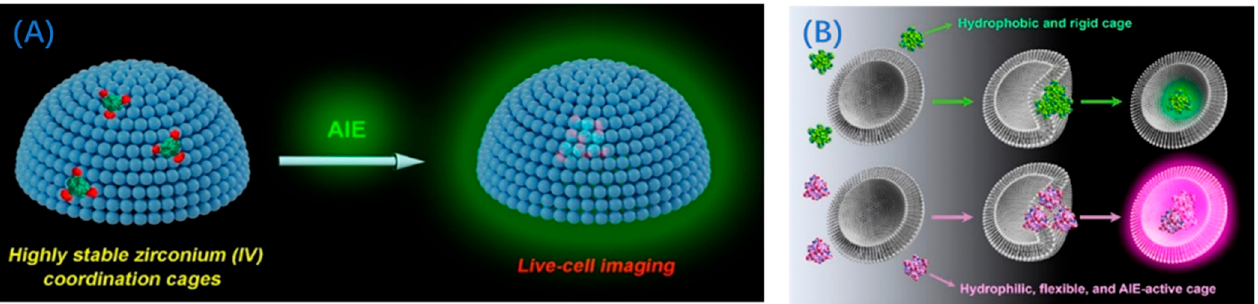
Figure 5. ( A ) Schematic diagram of the application of self-assembly of a highly stable Zirconium(IV) coordination cages containing AIE molecular rotors for live cell imaging (red color groups: the AIE molecular rotors). ( B ) AIE-active POCs with hydrophilic and stimuli-responsive properties for bi-